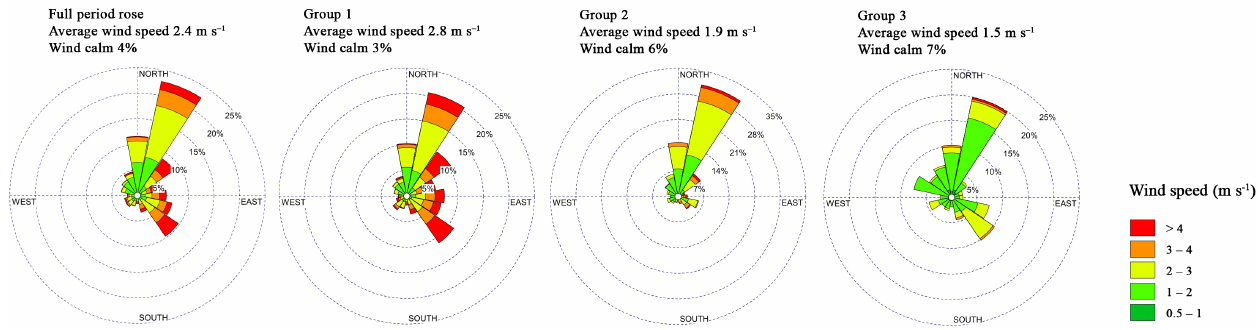
Fig. 4. Wind rose computed for each group identified by qHCA for UBG